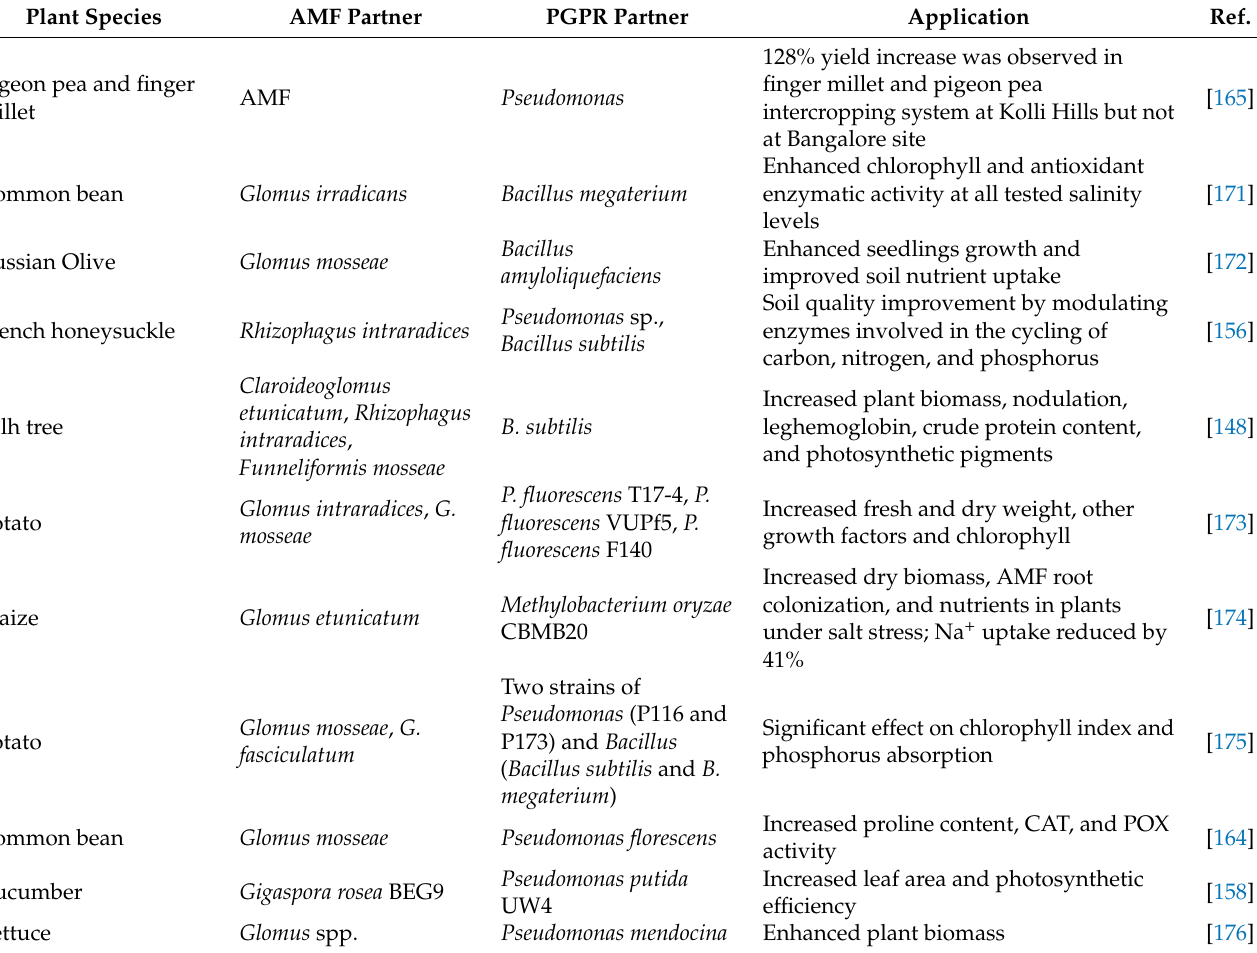
Table 4. Combined effect of PGPR and AMF under salinity stress in different